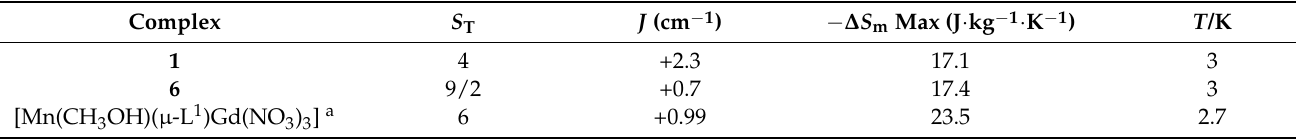
Figure 7. Top: Field dependence of the magnetization at different temperatures for 1 . The solid lines are a guide to the eye. Bottom: Magnetic entropy changes extracted from the experimental magnetization data for 1 . The solid lines represent the values calculated from the magnetic parameters ( J , g and zJ ) indicated in the text. Table 1. Maximum magnetic entropy change values ( − ∆ S m ) for complexes 1 and 6 and for [Mn(CH 3 OH)( µ -L 1 )Gd(NO 3 ) 3 ] at 7